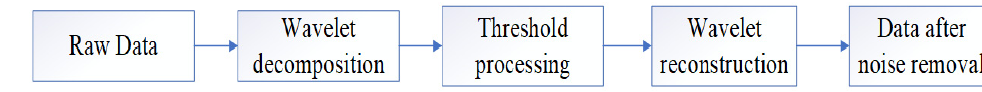
Figure 4. Data packet after outlier algorithm processing.